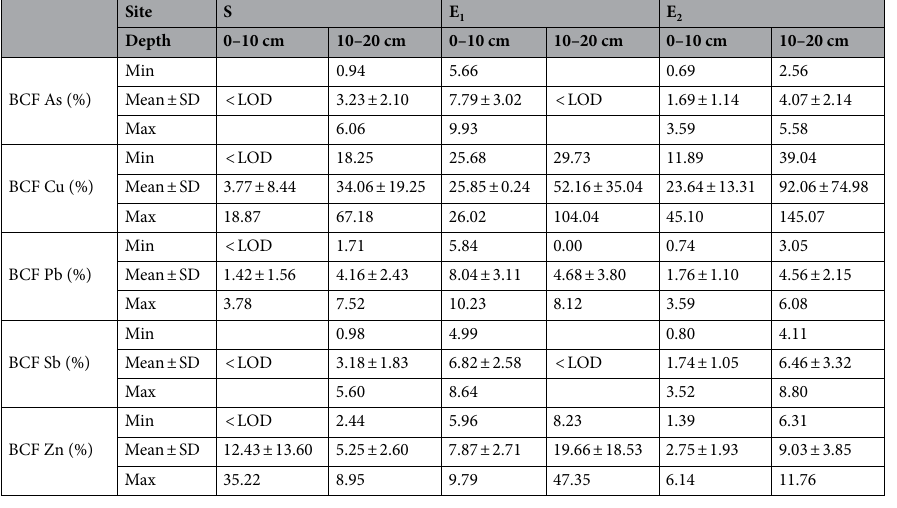
Table 5. Bioconcentration factors (BCF) i.e. ratios of Coronilla juncea root PTE concentrations vs. soil PTE pseudo-total concentrations for As, Cu, Pb, Sb and Zn. Min: minimum; Max: maximum; Means (n = 5); SD: standard deviation. Sites: S = reference site at Sormiou. E 1 = Escalette 1 and E 2 = Escalette